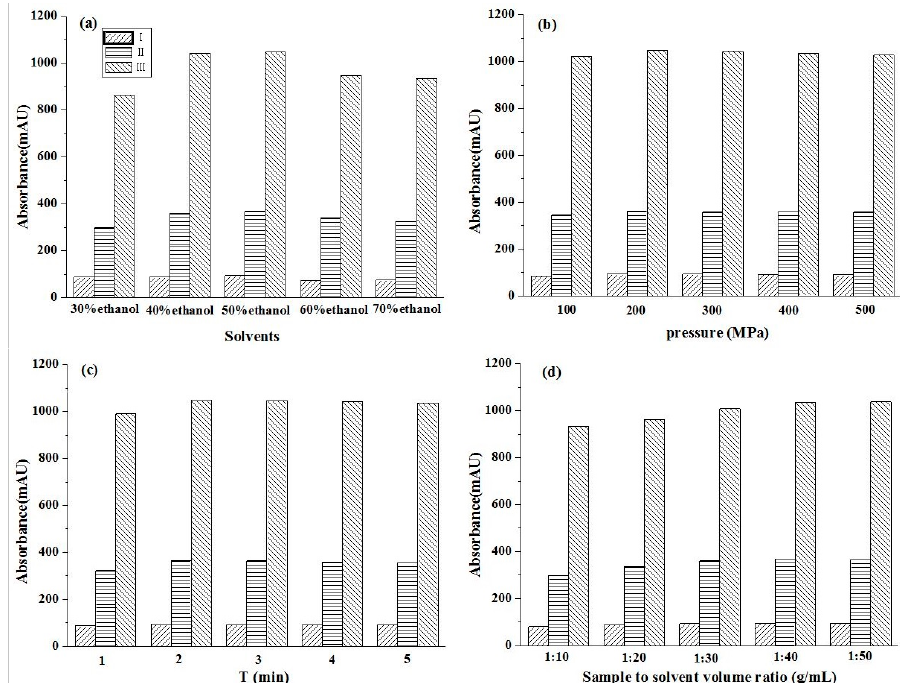
Figure 2. Effects of solvents ( a ), extraction pressure ( b ), extraction time ( c ), and sample solvent volume ratio (g/mL) ( d ) on the contents of target compounds by UPE. (I) β -D-glucopyranose 1-[(E)-3-(4-hydroxyphenyl)-2-propenoat]; (II) β -D- glucopyranose 1-[(E)-3-(3, 4-dihydroxyphenyl)-2-propenoat]; (III) 1-O-sinapoyl